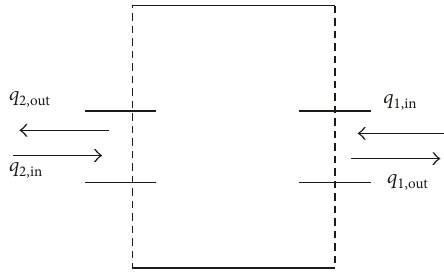
Figure 3: Visualisation of the case study